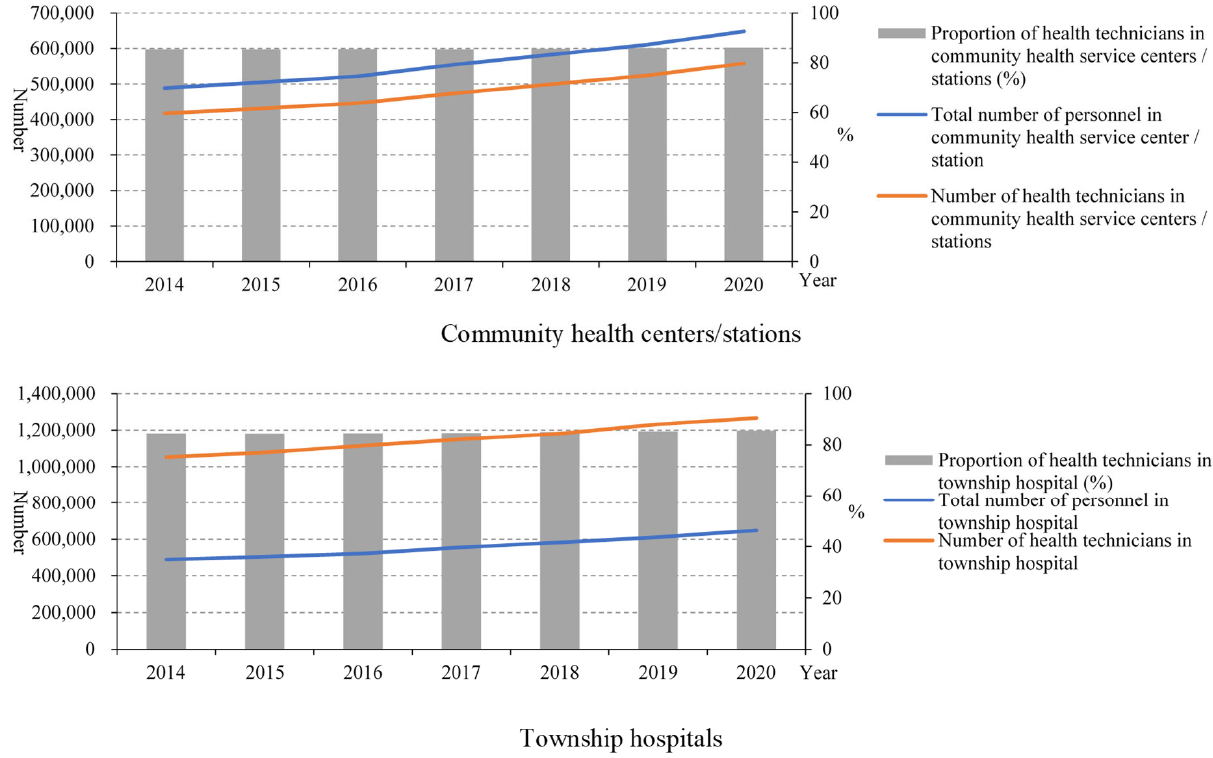
Figure 2. Personnel including health technicians in PHIs.